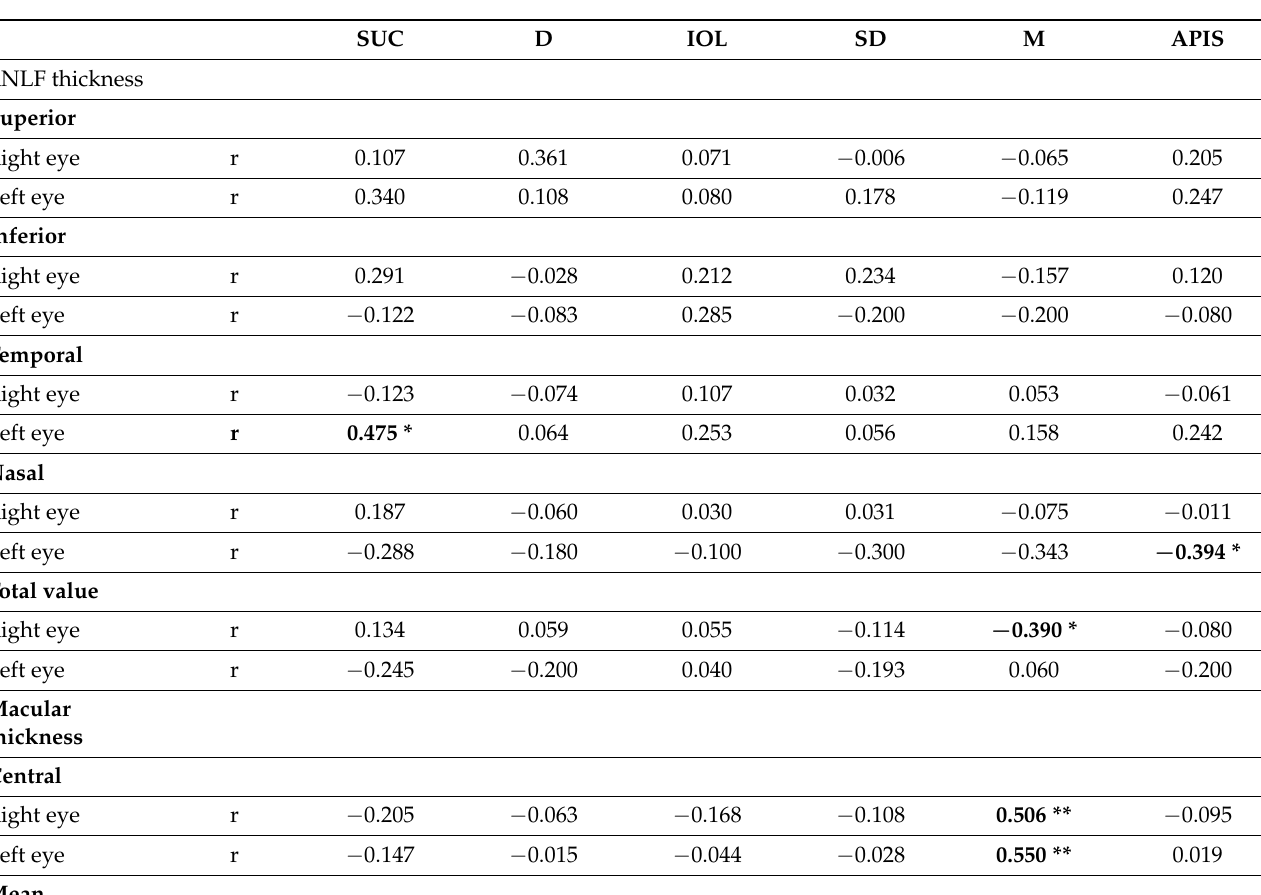
Table 3. Analysis of the correlation between APIS score and RNLF and macula